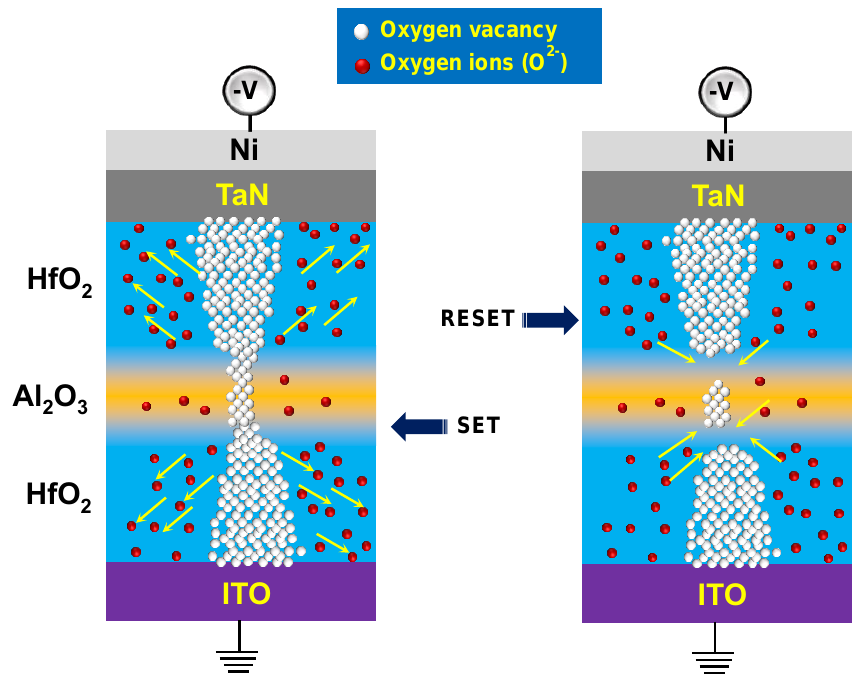
Figure 3. ( a ) Multiple initial forming characteristics under negative applied voltage to the top electrode and first RESET under positive voltage of TaN/HfO 2 /Al 2 O 3 /HfO 2 /ITO tri-layer RRAM device; ( b ) consecutive bipolar resistive switching characteristics of 200 SET/RESET cycles; ( c ) endurance characteristics of tri-layer RRAM device for 1300 switching cycles at a read voltage of 0.1 V; ( d ) memory retention of HRS and LRS for 10 4 s with a read voltage of 0.1 V.